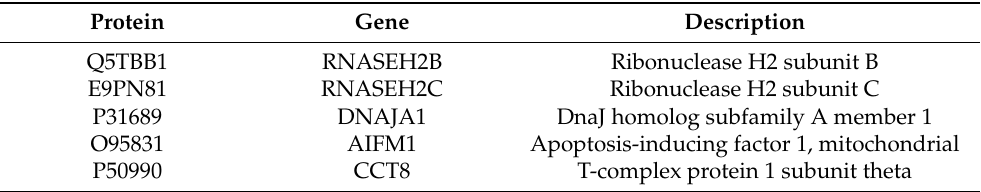
Table 4. List of proteins identified as binding partners of RNASEH2A by mass spectrometry analysis. The two top proteins, RNASEH2B and RNASEH2C, confirm the authenticity of the results. Protein Gene